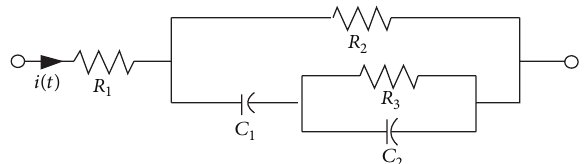
Figure 4: Equivalent electrical circuit for the heterogeneous reac- tion